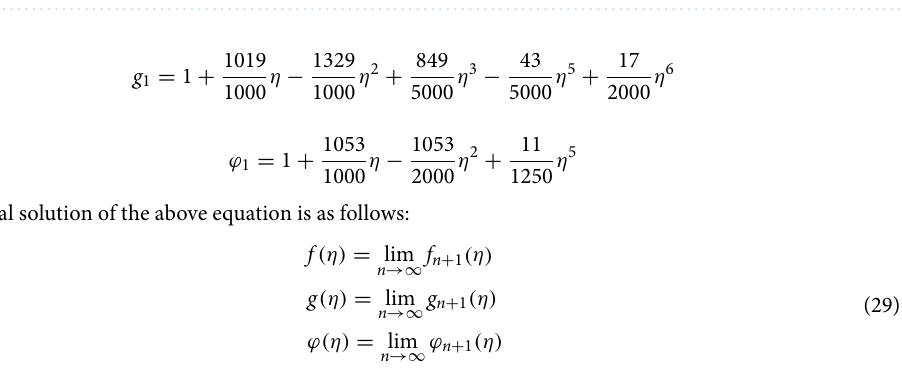
Figure 1. M influence on f ′